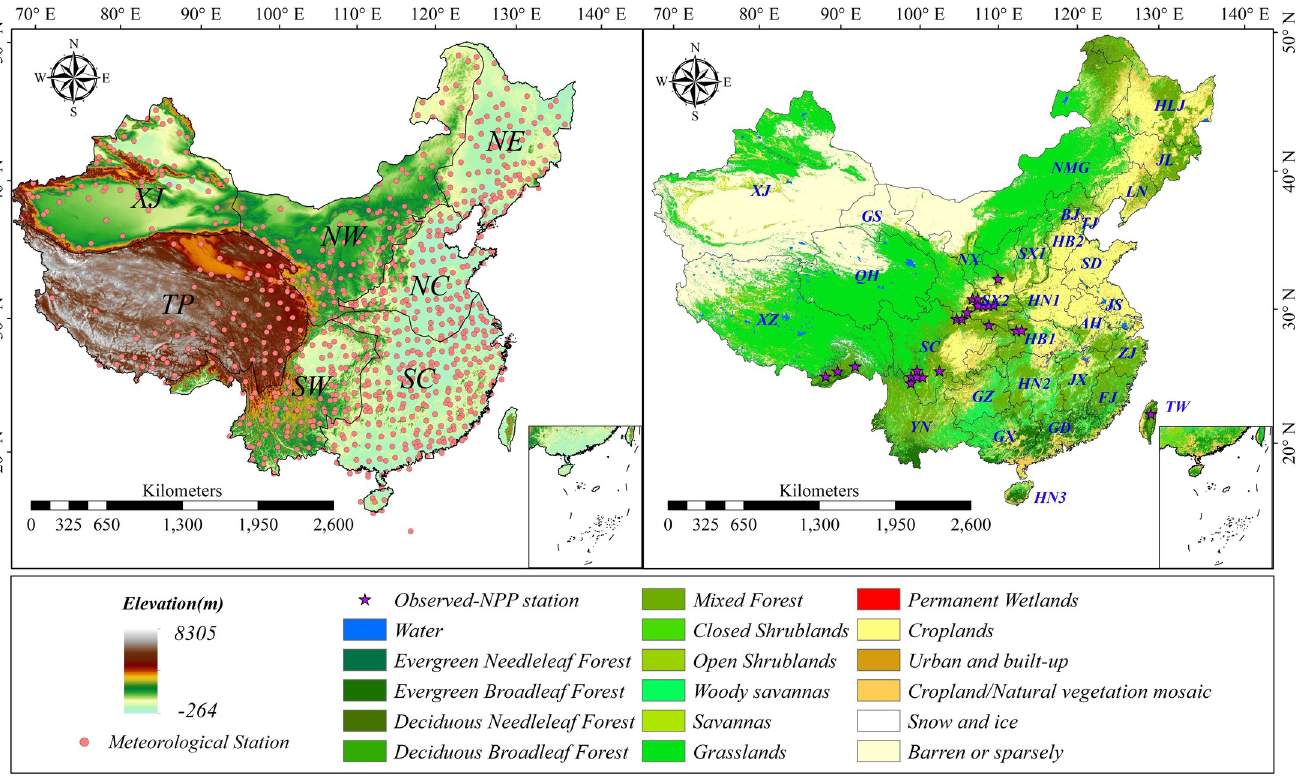
Fig 1. (a). Different regions of the study area according to the elevation and annual precipitation. The pink circles are 839 meteorological stations. (b). Land use of China. The 23 stars represent the observed-NPP stations from published papers, and these stations located in the temperate forest are mainly used to verify the potential